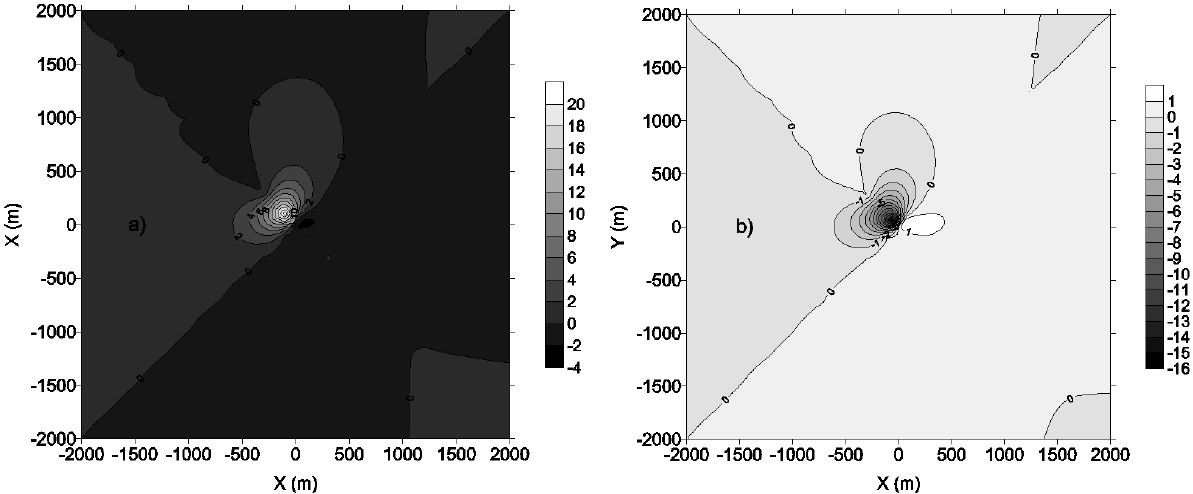
Figure 12. Concentration sensitivity to albedo. This is the relative variation of the concentration patterns according to Equation (5) ( D ). The results are in %. ( a ) and ( b ) are alb the 3 h averaging time first and second highest concentration; ( c ) and ( d ) are 24 h averaging time first and second highest